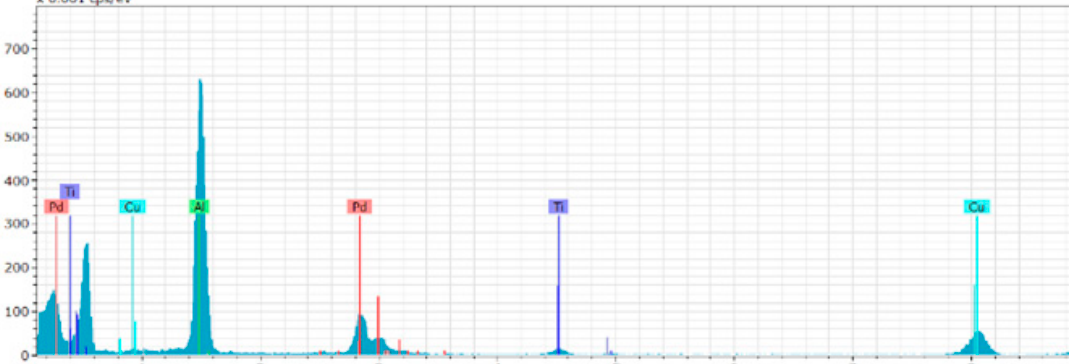
Figure 1. EDS spectra of the catalyst.